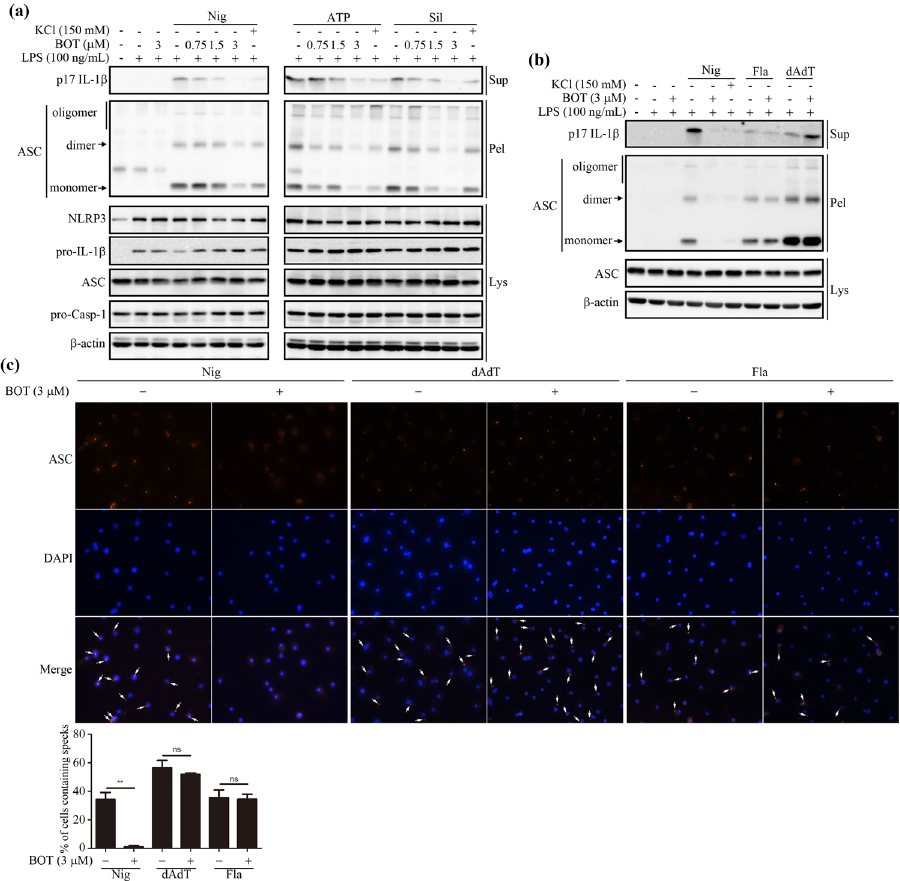
Figure 3. BOT-4-one blocks NLRP3-dependent ASC oligomerization. ( a ) LPS-primed BMDMs were treated with BOT-4-one at different concentrations or KCl for 1 h and then stimulated with nigericin (Nig), ATP, or silica crystals (Sil). ( b ) LPS-primed BMDMs were treated with BOT-4-one or KCl for 1 h and then stimulated with nigericin (Nig), poly(dA:dT) (dAdT), or flagellin (Fla). ( a and b ) ASC oligomerization in cross-linked cytosolic pellets was analyzed by immunoblot. Full-length blots/gels are presented in Supplementary Fig. S10a and b. ( c ) Representative immunofluorescence images of ASC speck formation are shown in LPS-primed BMDMs stimulated with nigericin (Nig), poly(dA:dT) (dAdT), or flagellin (Fla) in the presence or absence of BOT-4-one. The data represent the mean ± SEM of three independent experiments; ** p < 0.01; ns: